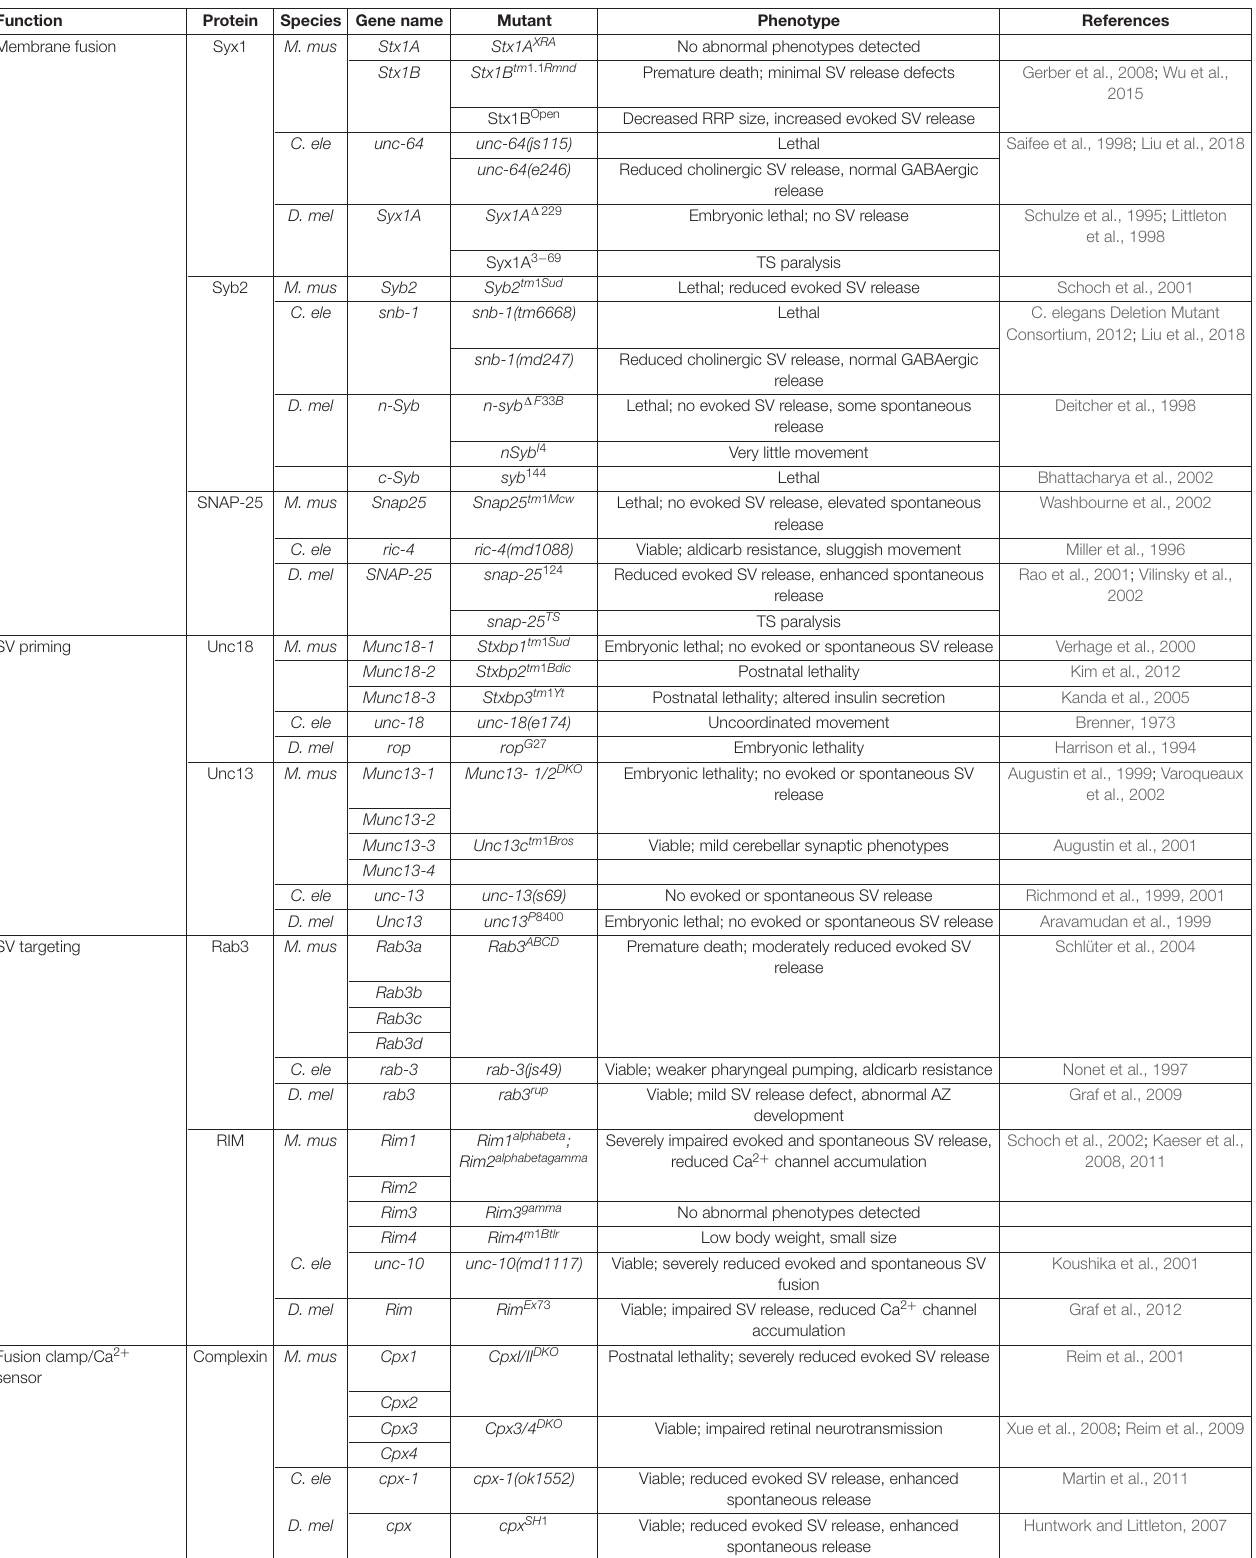
TABLE 1 | Summary of synaptic and behavioral phenotypes in Mus musculus ( M. mus ), Caenorhabditis elegans ( C. ele ), and Drosophila melanogaster ( D. mel ) SNARE and SRP mutants. Function Protein Species Gene